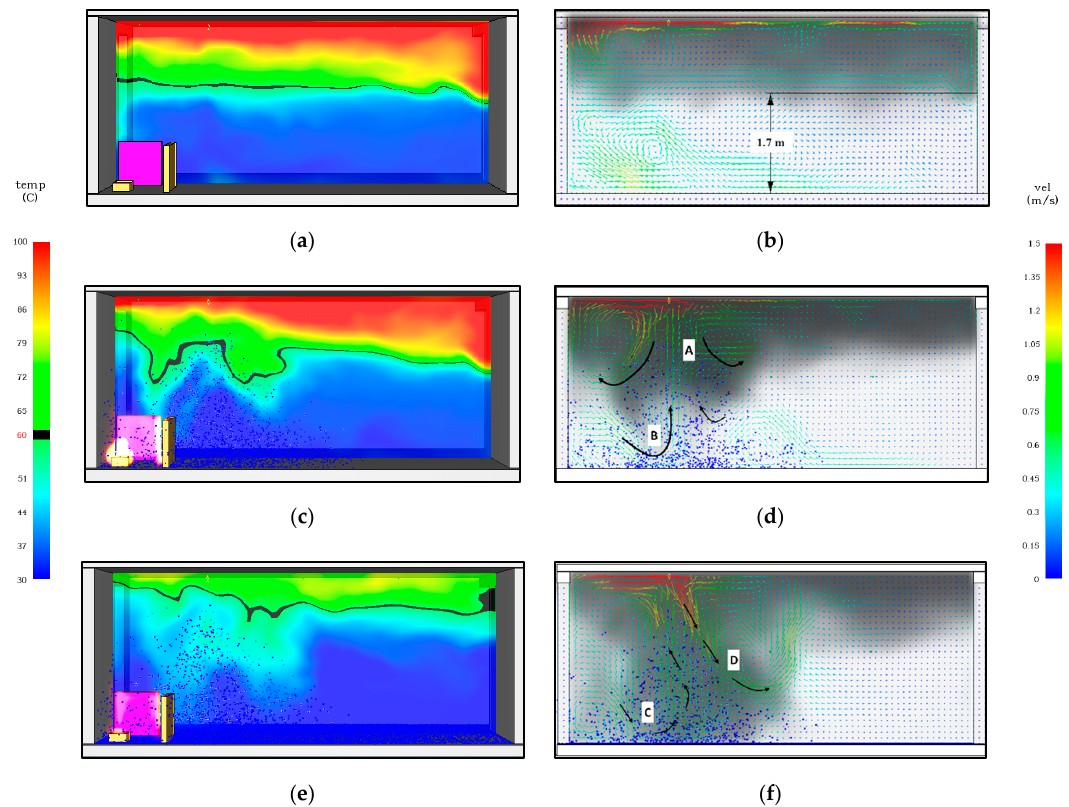
Figure 8. Temperature distribution and vector field of the smoke layer in vertical plane y = 0 m: ( a ) temperature distribution before sprinkler activation, 70 s; ( b ) velocity field before sprinkler activation, 70 s; ( c ) temperature distribution after sprinkler activation, 100 s; ( d ) velocity field after sprinkler activation, 100 s; ( e ) temperature distribution at 150 s; ( f ) velocity field at 150 s.